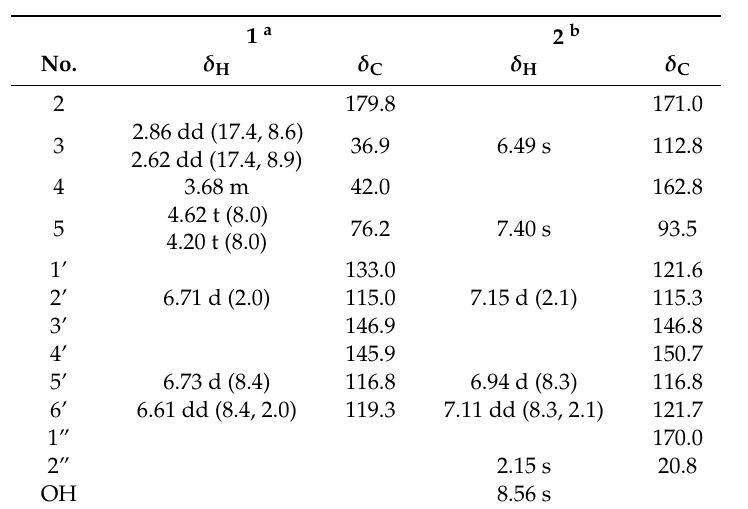
Figure 1. The chemical structures of compounds 1 – 28 . Table 1. 1 H- and 13 C-NMR spectral data of compounds 1 and 2 ( δ in ppm, J in